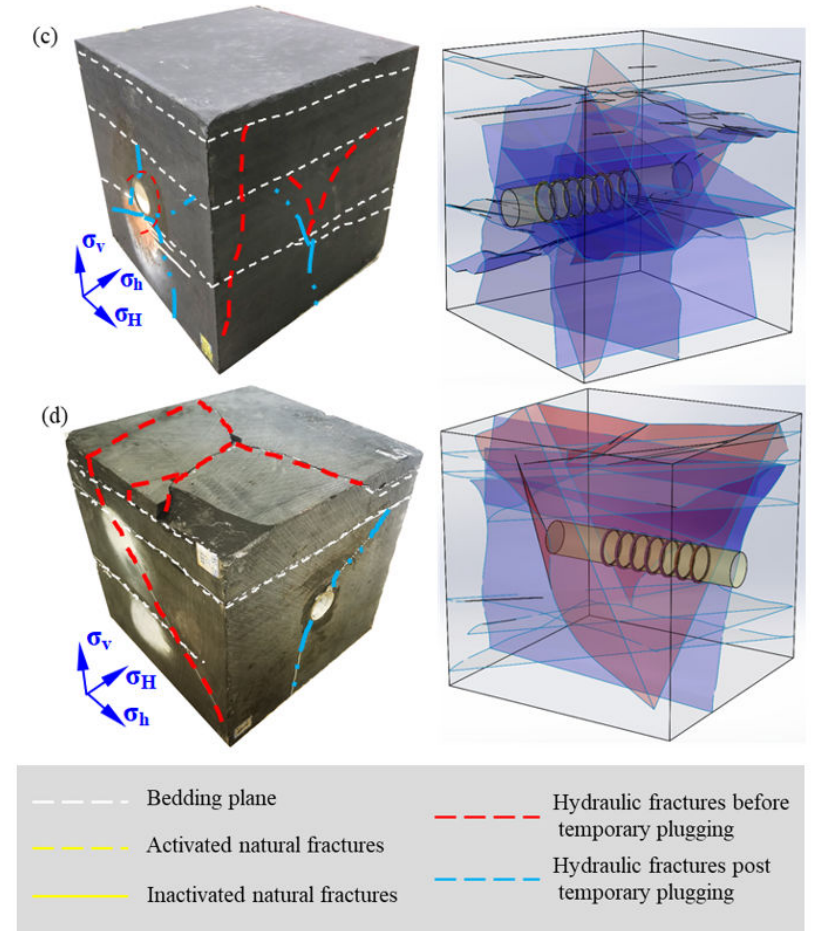
Figure 3. Fracture geometry and 3D reconstruction of temporary plugging fracturing under different size combinations of temporary plugging agents: ( a ) Specimen 1#, ( b ) Specimen 2#, ( c ) Specimen 3#, ( d ) Specimen 4# (left: apparent fracture geometry of rock sample, right: 3D reconstruction of fracture geometry).